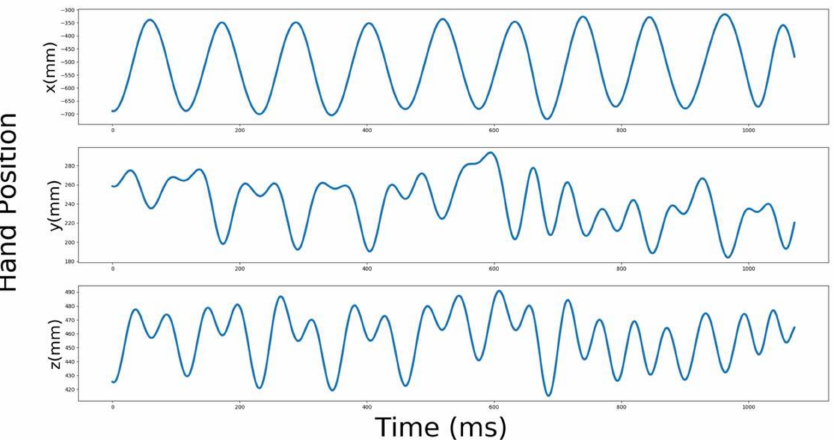
Figure 6. Recorded movement of the subject hand position. The top graph shows the position of the hand on the x-axis in time (ms), the middle graph shows the position of the hand on the y-axis in time (ms) and the bottom graph shows the position of the hand on the z-axis in time (ms). As Figure 7 shows, we combined the signals obtained from the cameras and calculated the standard deviation of the orthogonal